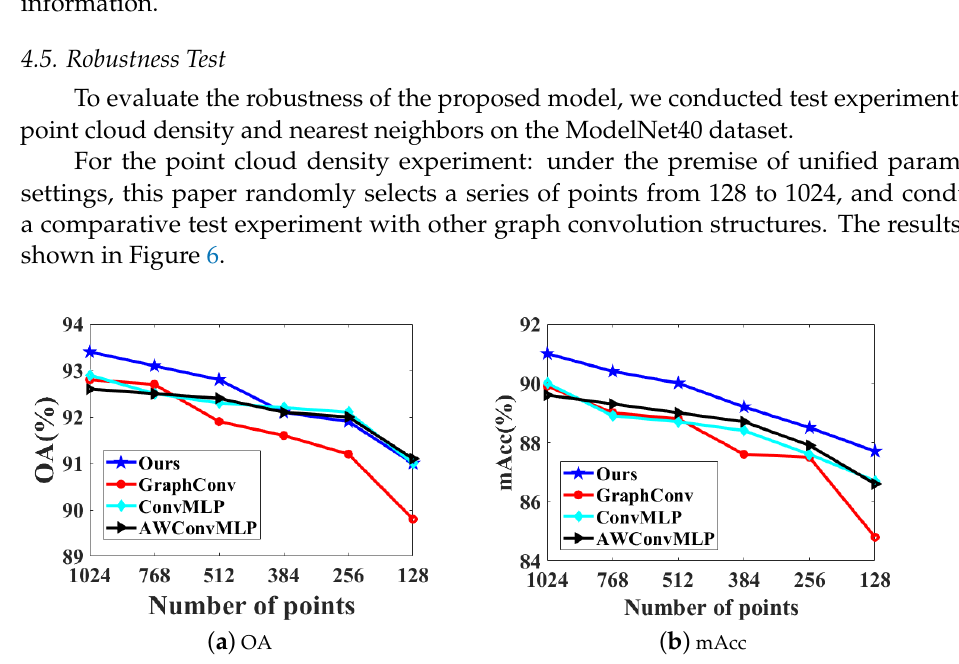
Figure 6. Robustness test on ModelNet40 for classification. GraphConv indicates the standard graph convolution network. ConvMLP indicates that we replace the ablation of the AWConvMLP layer in GC-MLP with ConvMLP. AWConvMLP indicates that we replace the ablation of the ConvMLP layer in GC-MLP with